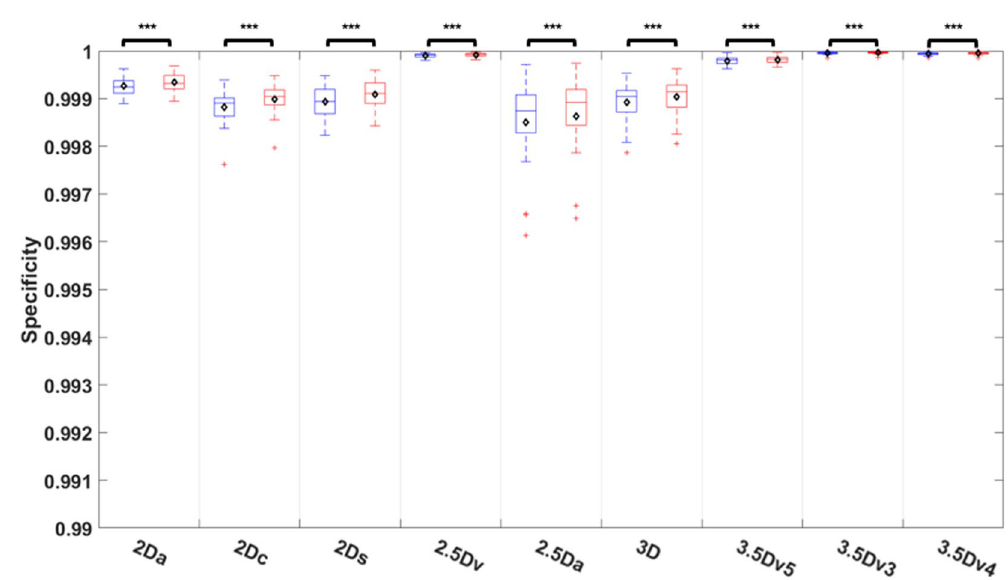
Figure 7. Comparison of specificity among 9 U-Nets before and after